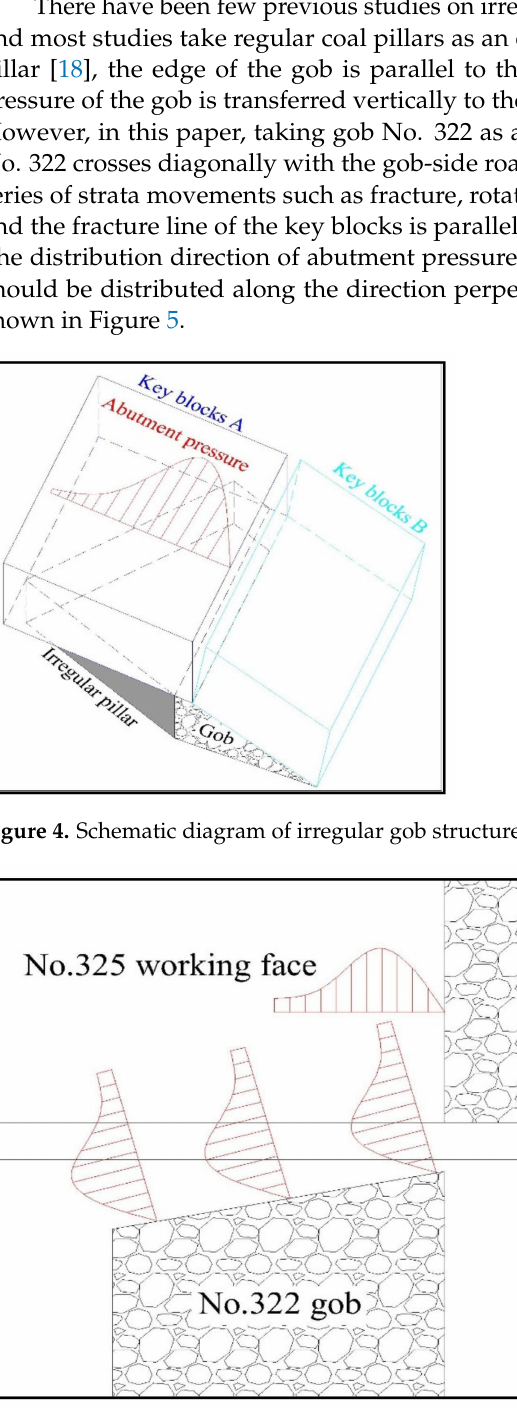
Figure 5. Abutment pressure distribution diagram of irregular